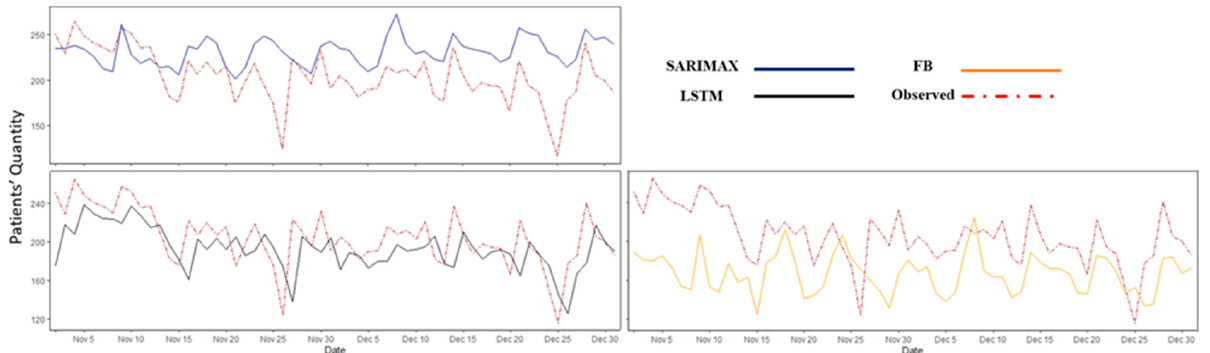
Figure 8. The multivariable model predicted values vs. observed data (i.e., test data) for the ED patient arrival with a one-day forecast horizon. SARIMAX: seasonal autoregressive integrated moving average exogenous, LSTM: Long Short-Term Memory, and FP: Facebook Prophet. Table 4. RMSE and MAE values for multivariable models in five different forecasting horizons. Forecasting Horizon (in days) Models